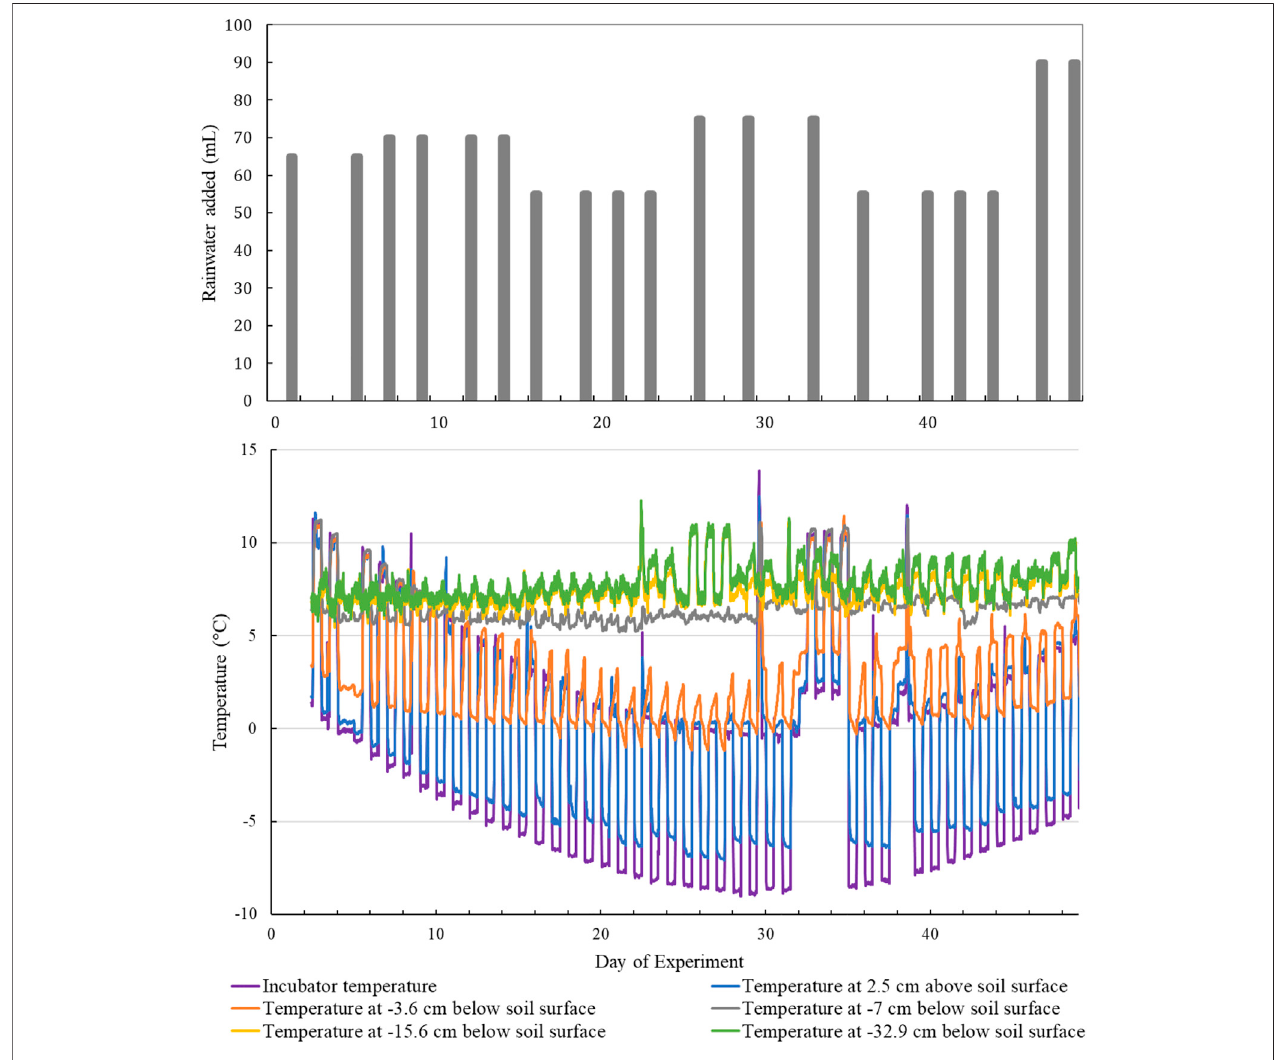
FIGURE 2 | The top graph shows total applied volume of arti fi cial rainwater over the course of the experiment. The bottom graph shows air temperature and soil temperature at various depths over the course of the experiment. Soil temperatures were measured at different depths below the soil surface in one of the columns and treated as representative for all columns. The 1-day thaw occurs around Day 30 and the 3-day thaw occurs around Day